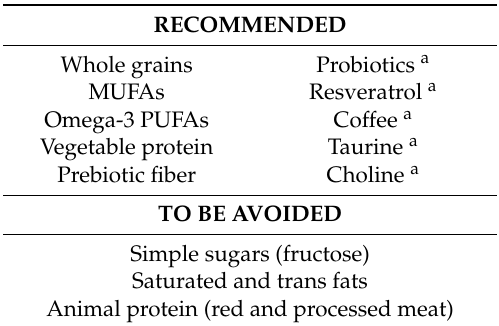
Table 1. The summary of dietary indications for the treatment of non-alcoholic fatty liver disease (NAFLD).